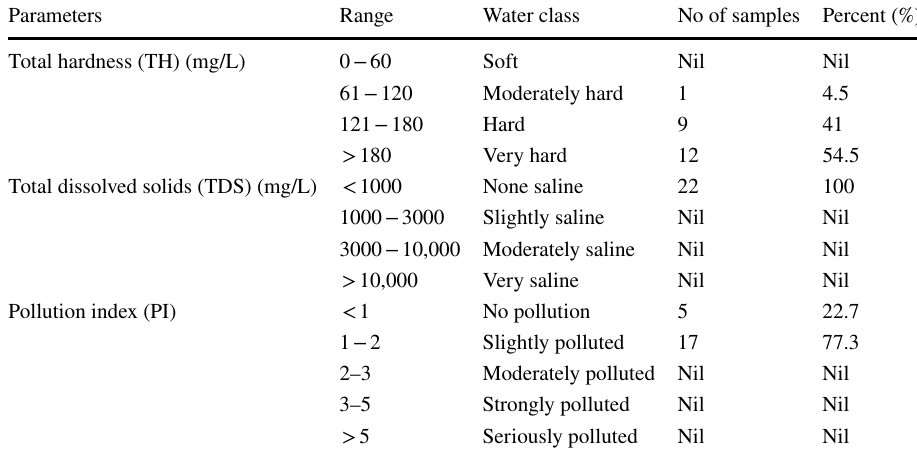
Table 2 Classification of groundwater samples of the study area on the basis of TH and TDS